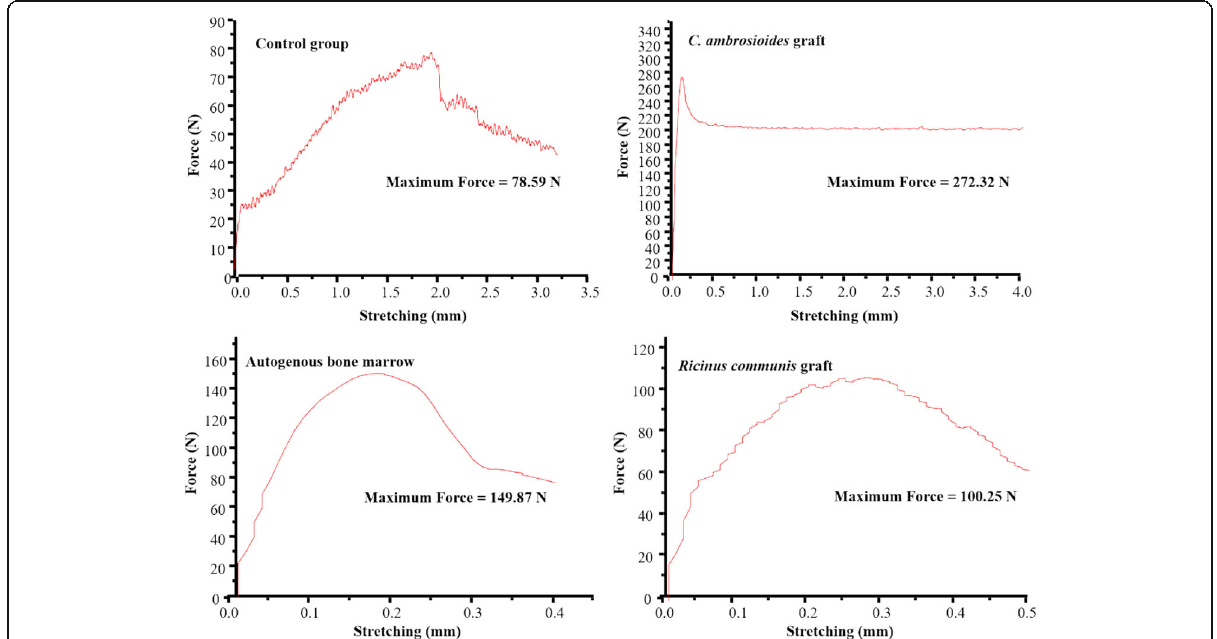
Fig. 5 Effect of a graft of lyophilized aqueous Chenopodium ambrosioides L. extract on bone formation. Biomechanical analysis at 90 days. The results are reported as maximum force (Fmax). Groups: Control group, C. ambrosioides graft, Autogenous bone marrow e Ricinus communis graft